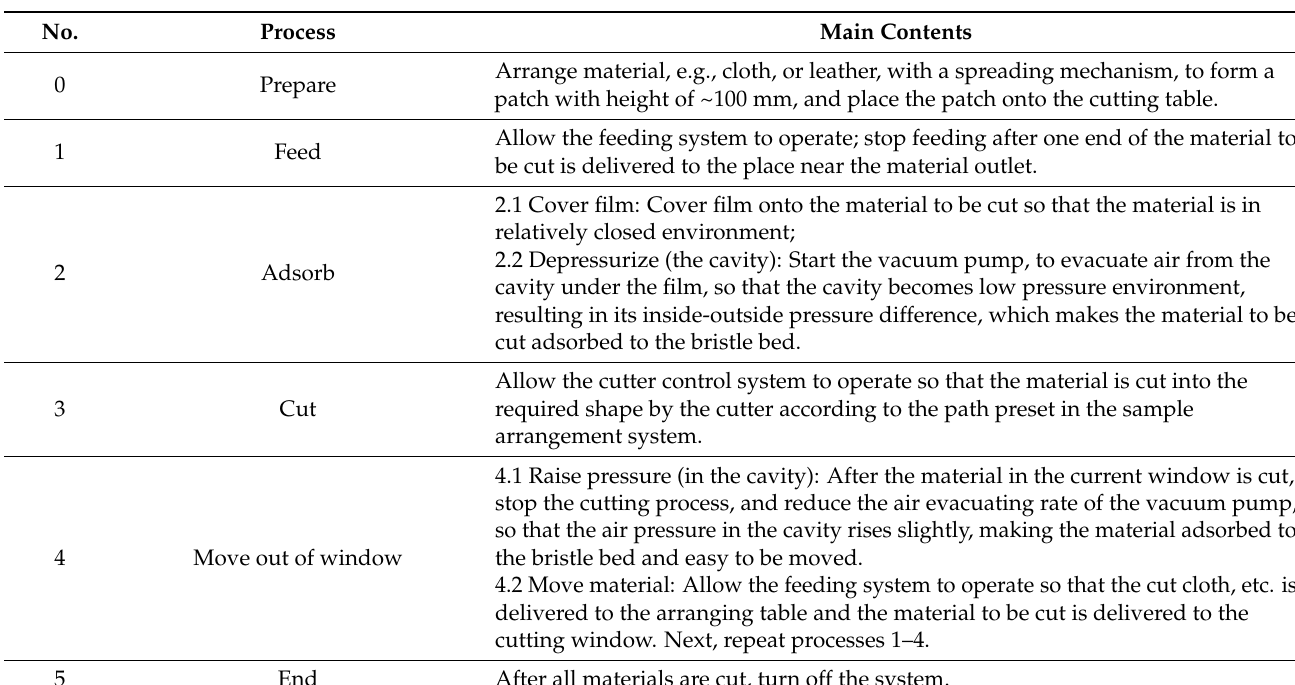
Figure 6. Schematic diagram of working of cutting machine. Table 2. Working processes of cutting